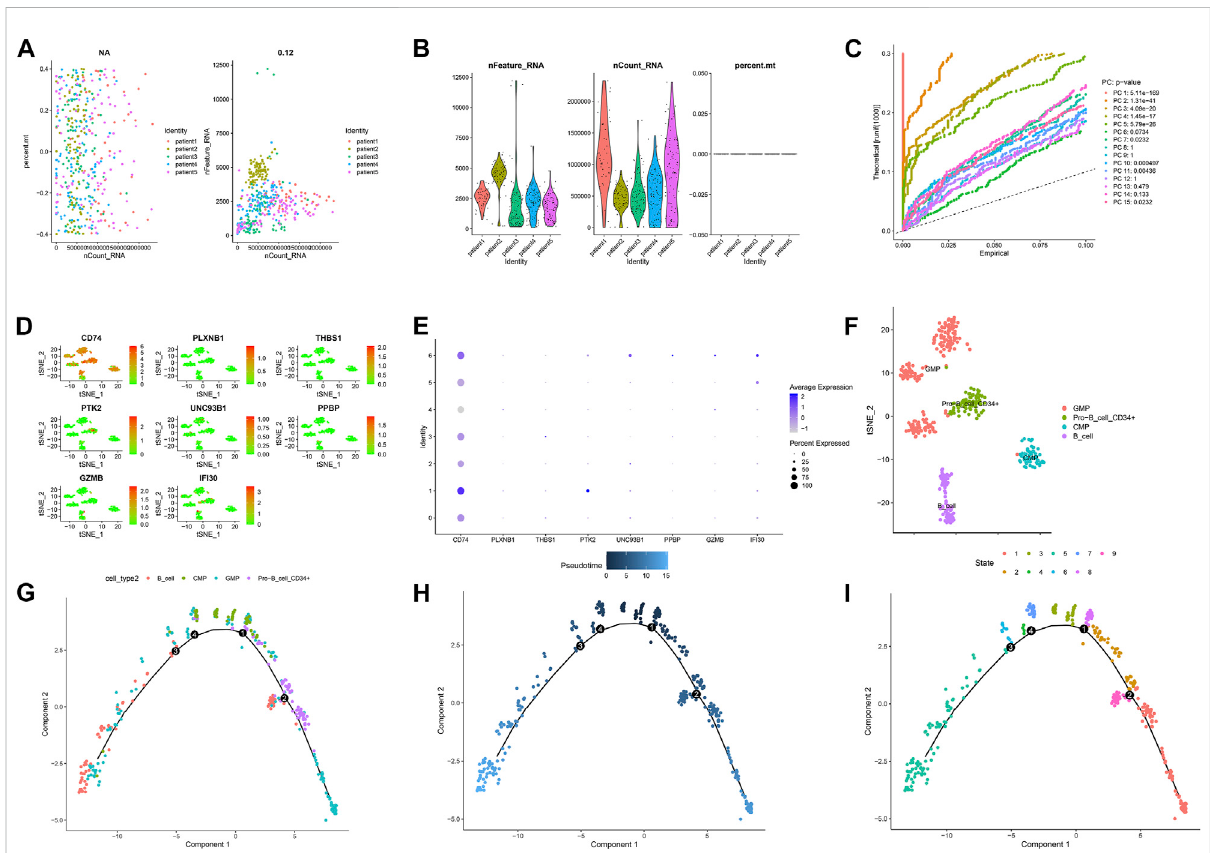
FIGURE 8 Single-cell sequencing results and pseudotime differentiation in AML patients at relapse. (A) RNA count charts of 5 patients. (B) Sequencing depth, gene count, and mitochondrial content of 5 patients. (C) PCA dimension reduction was performed on characteristic genes. (D – E) Expression of 7 prognostic genes in cell subsets. (F) Annotation results of cell subsets. (G) Sequence of different cell clusters along pseudo-time. Infer cell sequence from expression of the most dispersed genes in the cell cluster. Each point corresponds to a cell, and each color represents a state. (H) The darker the blue, the earlier the differentiation, and the lighter the blue, the later the differentiation. (I) Each color represents a different